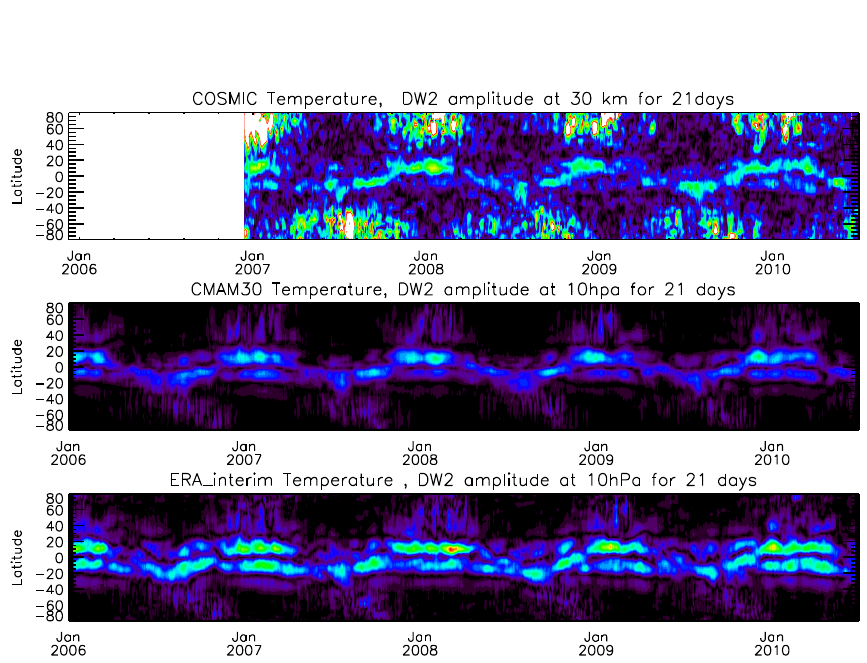
Figure 7. Latitude versus time variation of amplitudes of non-migrating tides, DS0 (in top three panels), and DW2 (in bottom three panels) at 30 km from COSMIC observations, and at 10 hPa from CMAM30 and ERA-interim data obtained using a 21-day window.